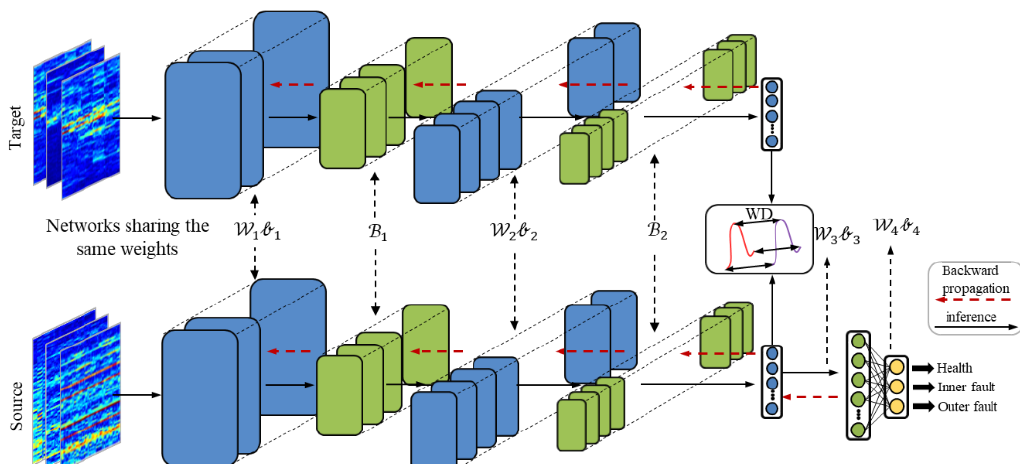
Figure 3. The architecture of the proposed WDA. In the testing phase, the feature maps from the target domain are directly fed into the classifier.